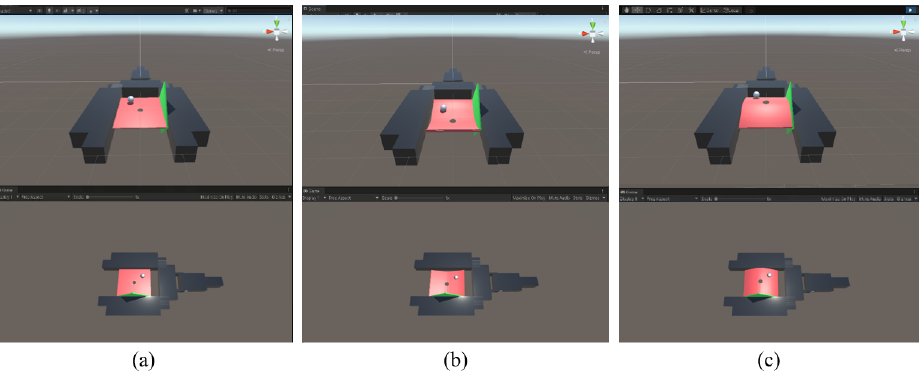
Figure 6. Virtual wrist–hand system and a robotic agent: ( a ) a flat plane, ( b ) a convex plane, and ( c ) a concave plane. Two-DoF spherical wrist joint action is only used to solve the given geduldspiele